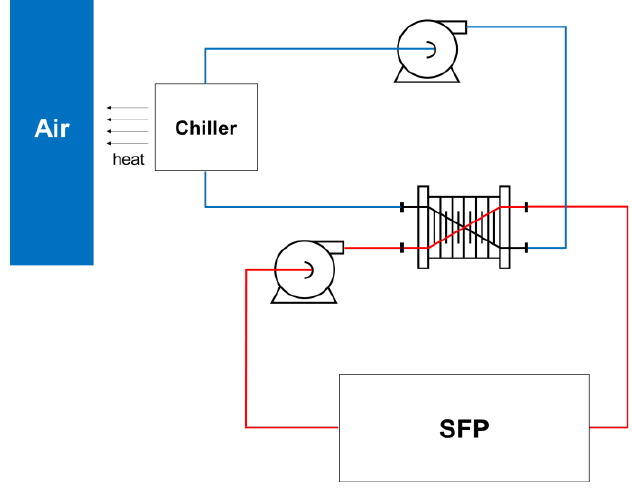
Figure 5. Schematic of air-cooled indirect heat exchange system.